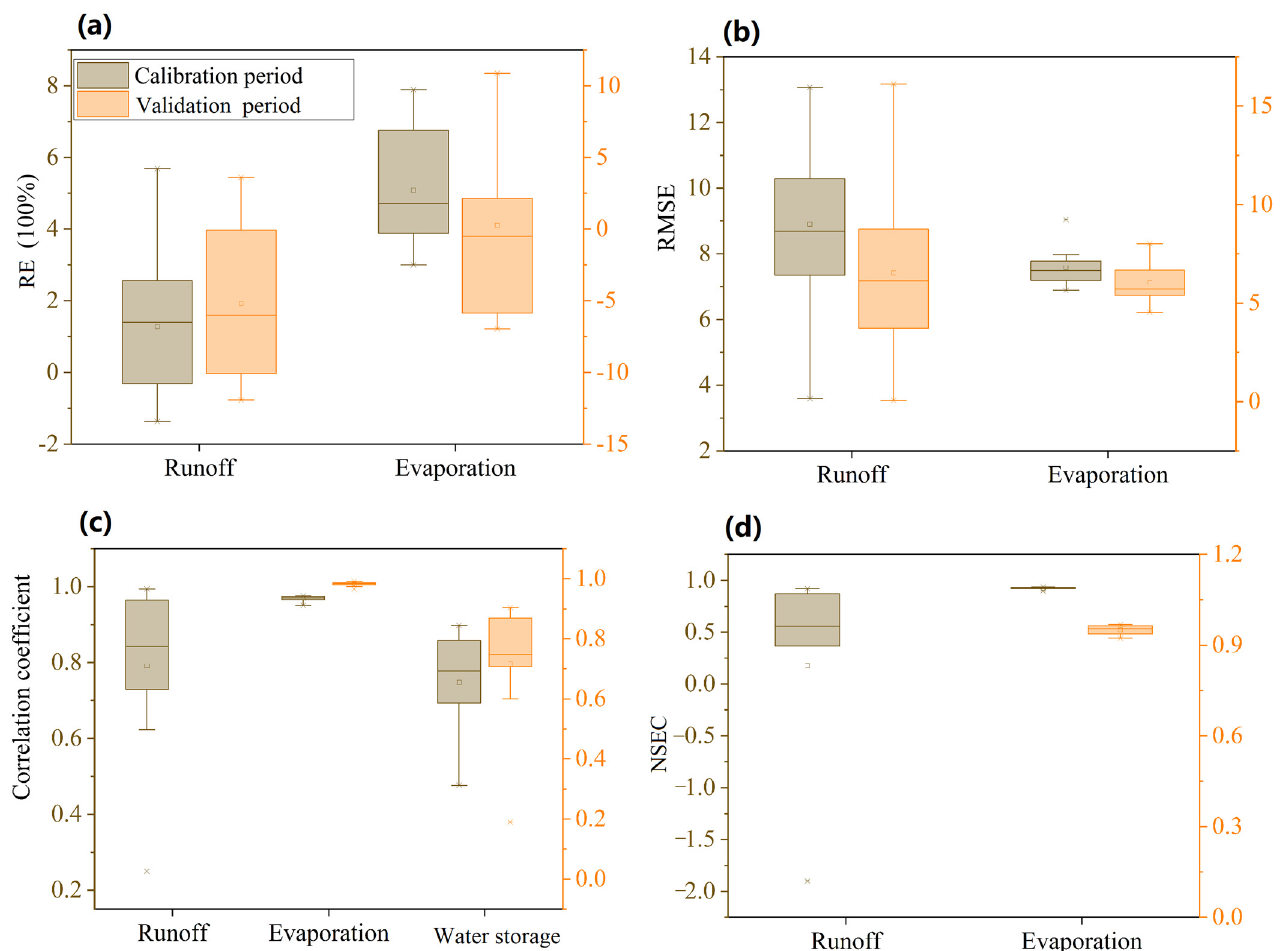
Figure 7. Distribution box diagrams of the model performance metrics for three hydrological elements (i.e., runoff, evaporation, and water storage) for the ten sliding window periods. Four statistical metrics were as presented as (a) RE, (b) RMSE, (c) CC, and (d) NSEC, respectively.